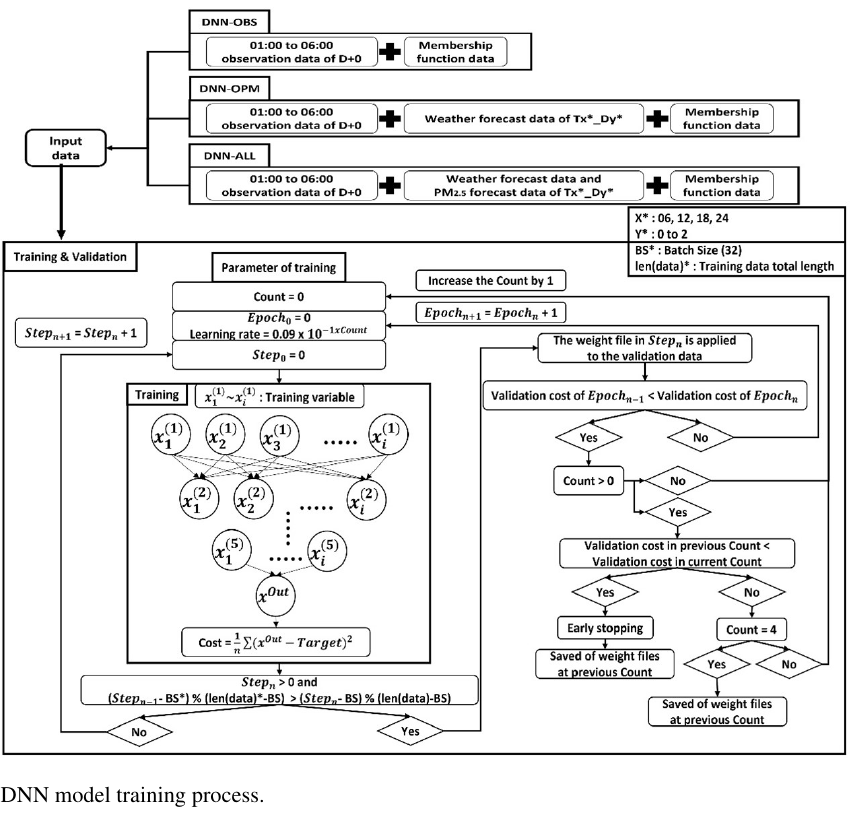
Figure 4. Structure of DNN model training process.